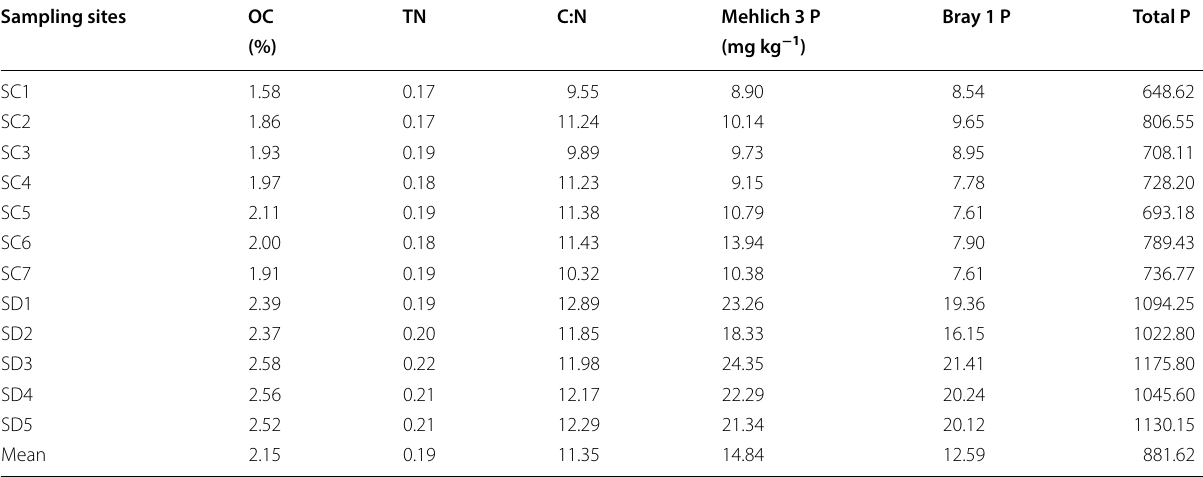
Table 5 Organic carbon (OC), total nitrogen (TN), available and total phosphorus (P) OC nitrogen, C:N carbon to nitrogen ratio =